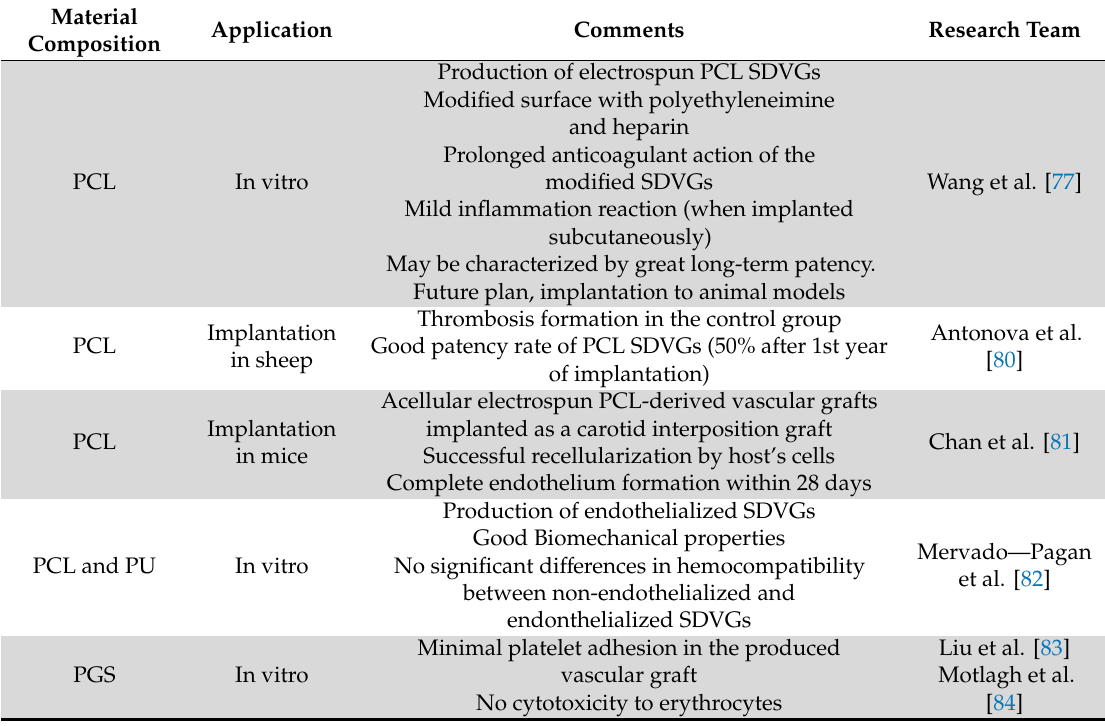
Table 2. Representative applications of TEVGs derived from degradable